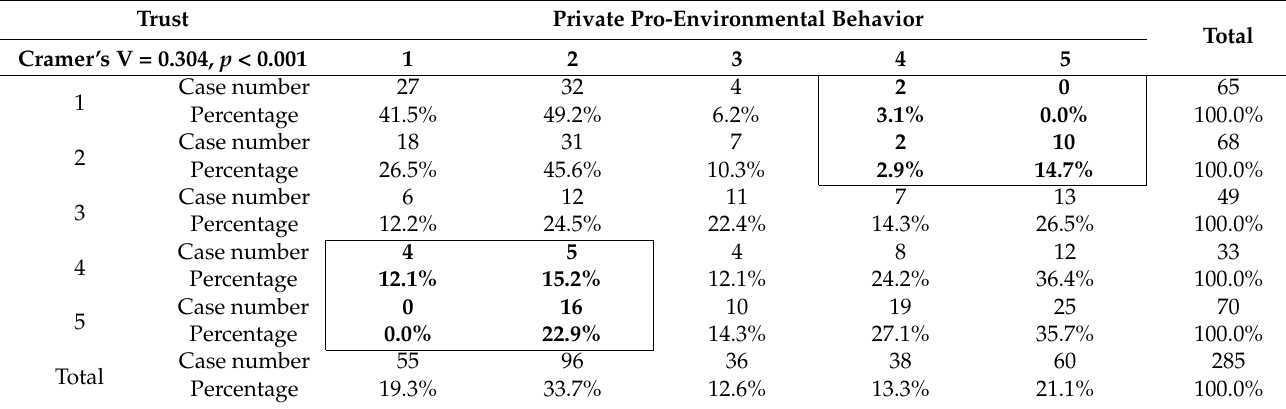
Table 8. Cross-contingency table of trust and private pro-environmental